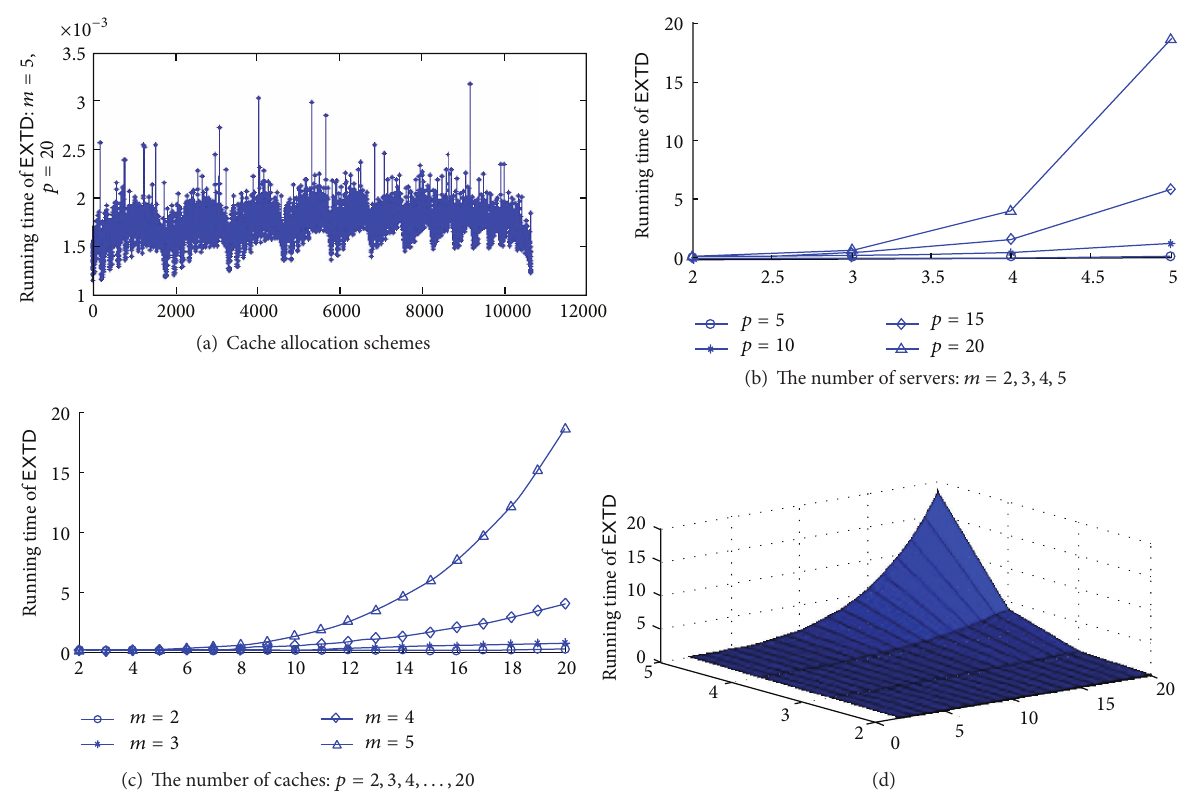
Figure 5: Compare the running times of EXTD for 𝑚 = 2, 3, 4, 5 and 2 ≤ 𝑝 ≤ 20 and fixed 𝑛 = 200 or